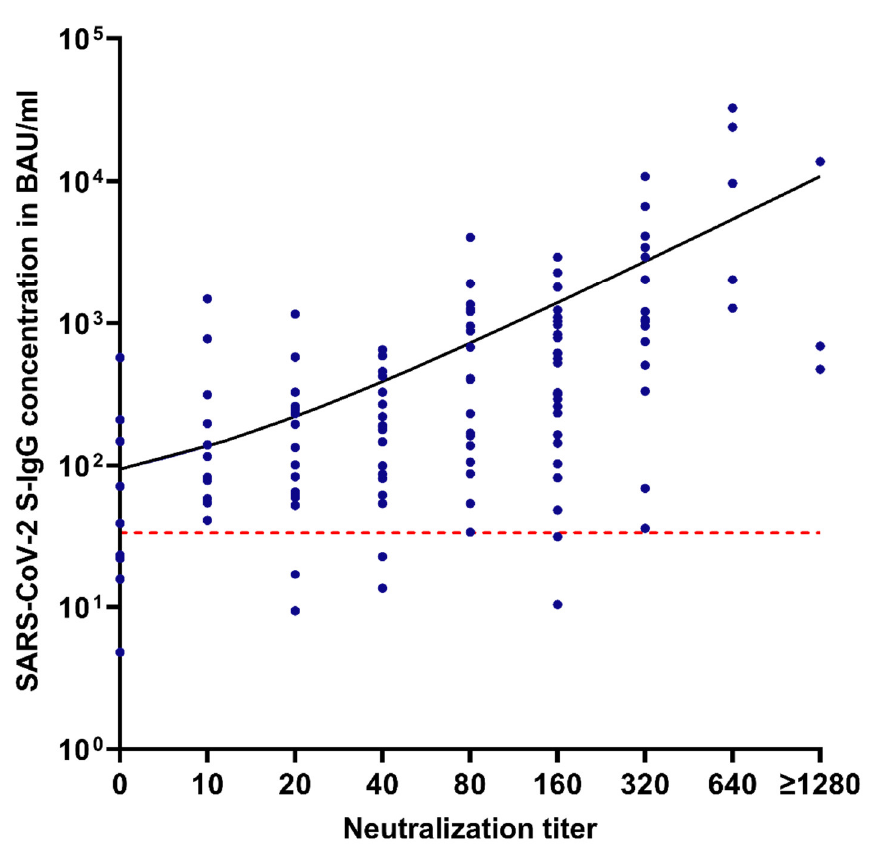
Figure 5. Correlation of neutralization titers and SARS-CoV-2 S-IgG antibody concentrations in BAU/mL. Red dotted line = manufacturer’s positive cut-off at 33.8 BAU/mL.